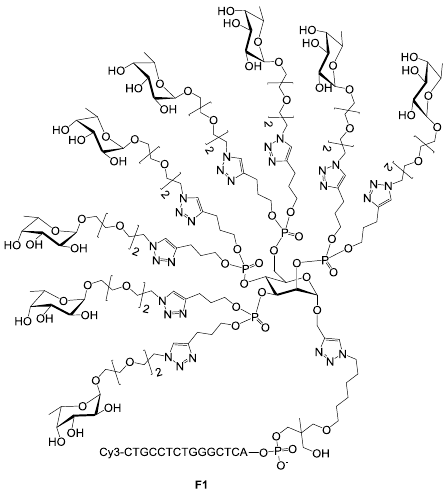
Figure 1. Structure of the fucosyl cluster F1 used for the first screening.